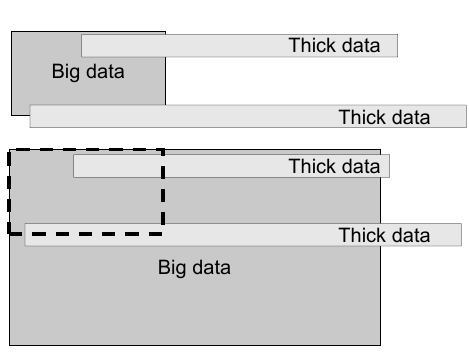
Fig. 4 Increased overlap causing the accuracy-correlation effect.